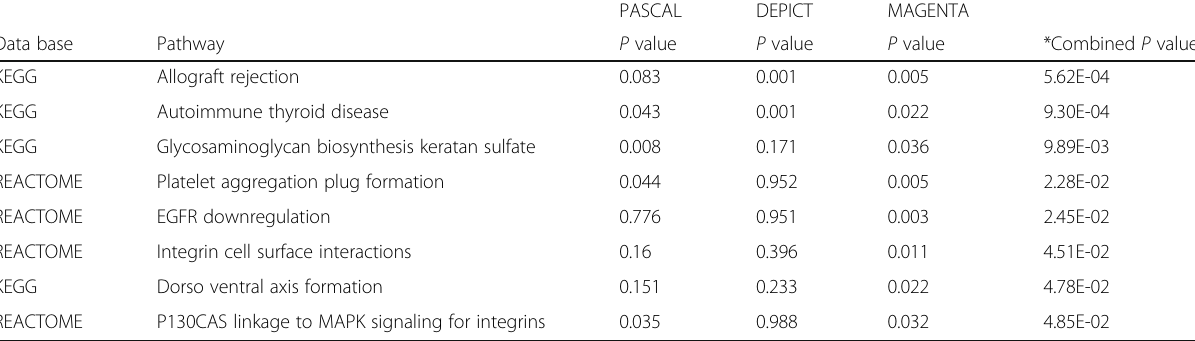
Table 3 Combined results of gene set enrichment analysis from MAGENTA, PASCAL and DEPICT. Pathways are pooled from several repositories which are enlisted with data base. P values from PASCAL, DEPICT and MAGENTA are corrected for multiple testing PASCAL DEPICT MAGENTA Data base P